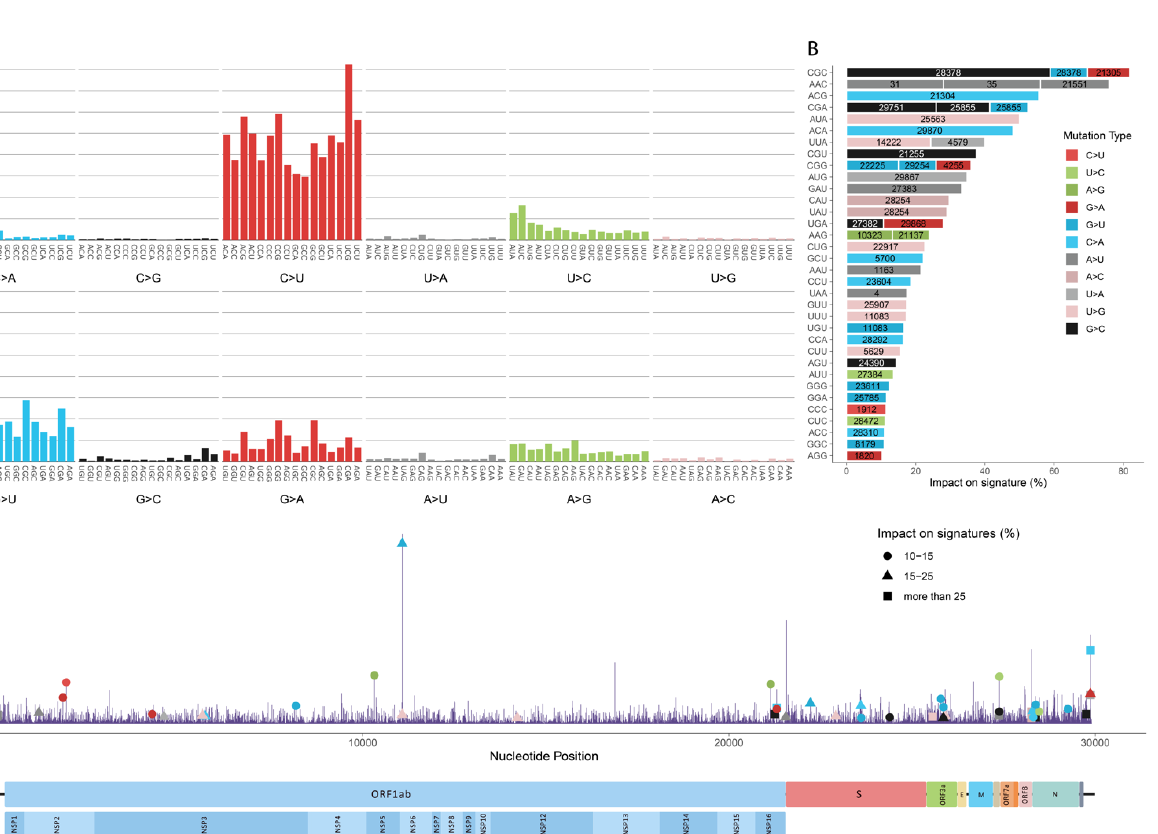
Figure 2. Mutation profile of SARS-CoV-2 genomes. Mutation counts are normalized by the trinucleotide content for each trinucleotide generated from 33,540 (representative sequences and nodes) sequences ( A ). From unstable positions where more than 8 mutations of the same type at the same position, highly occurred mutations are retrieved. The occurrences of these mutations are divided by the total number of the mutations of the same type and observed in the same trinucleotide. The calculated ratio is used to visualize the impact of highly occurring mutations on signature profile, as percentages ( B ). The bars are labelled with their positions in the genome. Number of mutations observed in the phylogenetic tree, per position ( C ). Mutations which have a significant contribution to their signature visualized in part B are marked according to the mutation count they represent at the position. Marked mutations are colored and reshaped with respect to their mutation type and impact range on their signatures.